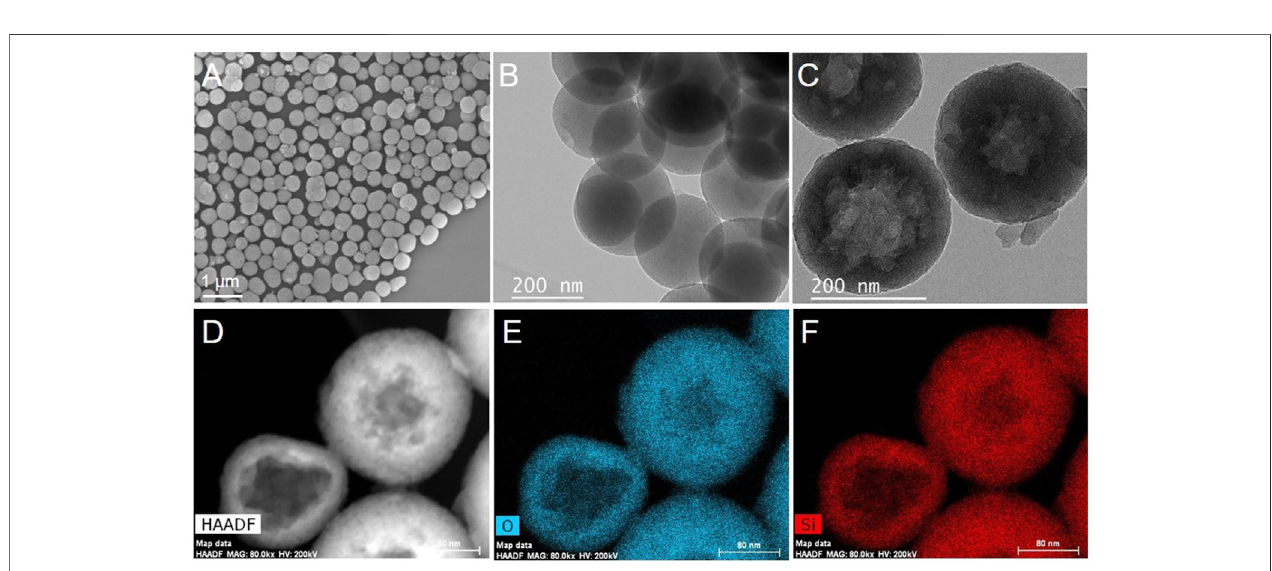
FIGURE 2 | (A) SEM and (B) TEM images of m SiO 2 , (C) TEM and (D) HAADF-STEM images of HMS and (E) O and (F) Si element mapping of HMS.